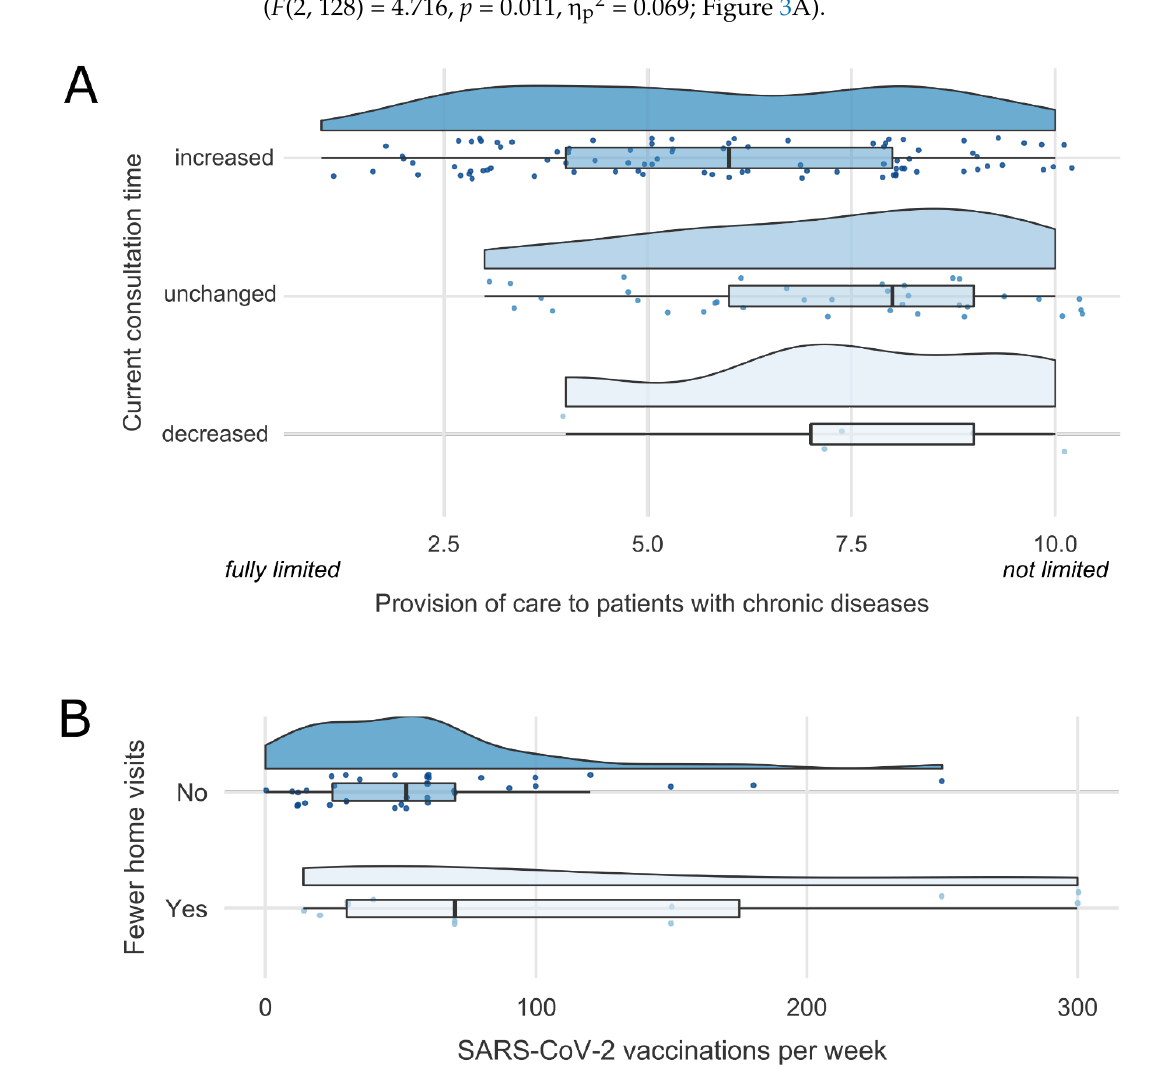
Figure 3. Influence of the pandemic on provision of care to other patient groups. ( A ) Baseline 2021: